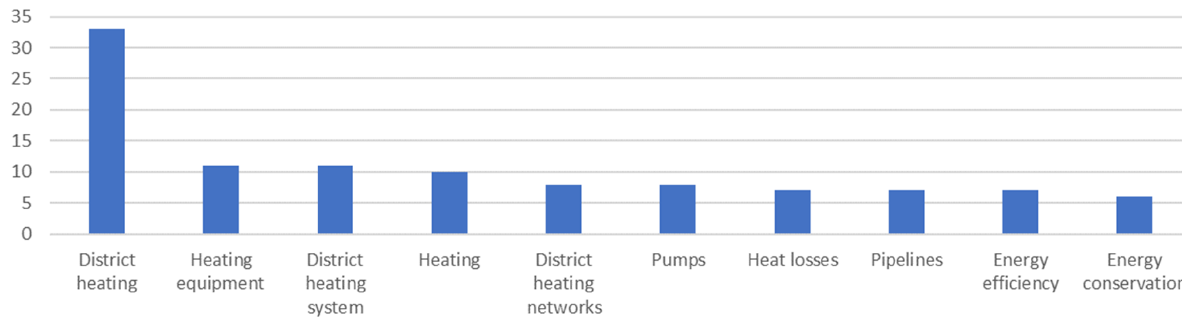
Figure 7. Distribution—most frequent keywords (horizontal axis) and the number of articles (vertical axis).